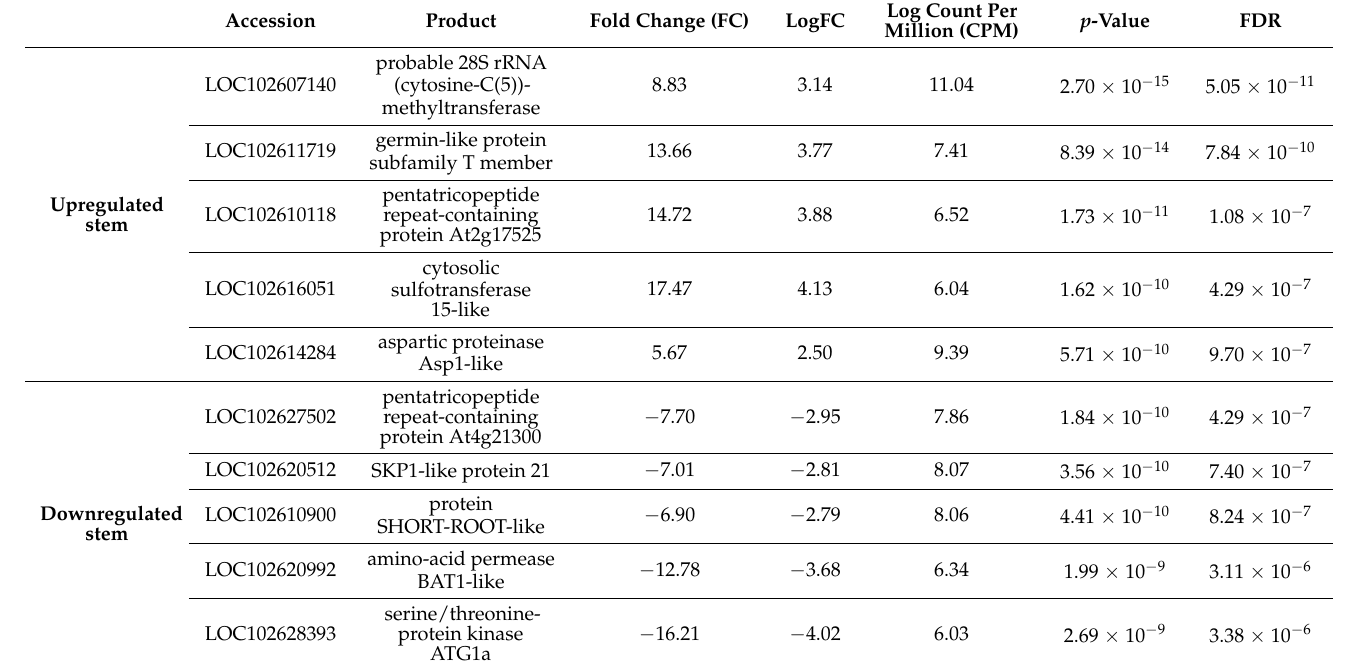
Table 3. List of top 5 up and downregulated differentially expressed genes (DEGs) in non-infected vs. citrus dwarfing viroid (CDVd)-infected for stem tissues based on the